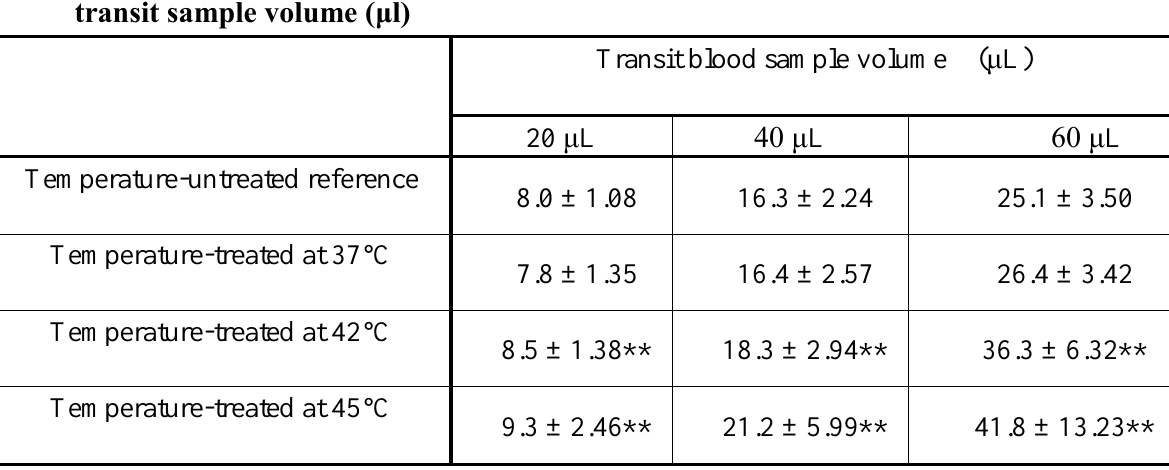
Table 1. Summary of the mean ± standard deviation of transit time of blood samples (s) for a given transit sample volume (μL). Prior to application of MC-FAN, blood samples were subjected to mild heating at 37 °C, 42 °C and 45 °C for 30 min, respectively. The number of subjects was 10. Significant differences ( p < 0.001) of the temperature-treated samples against the temperature-untreated reference were shown as